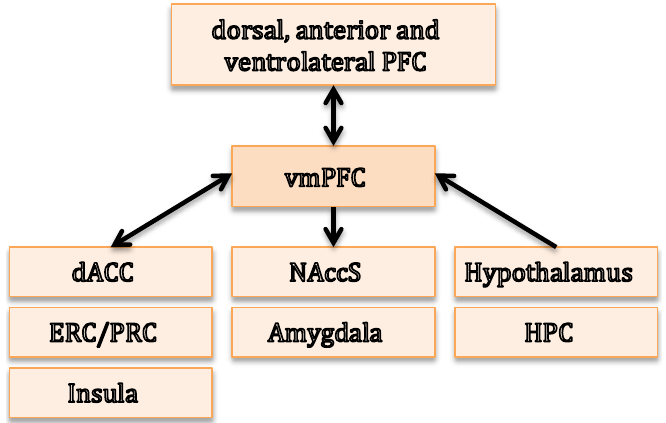
Figure 3. Principal connections from and to the ventromedial prefrontal cortex (vmPFC) adapted from [32]. dACC = dorsal anterior cingulate cortex; ERC = entorhinal cortex; PRC = perirhinal cortex; NAccS = nucleus accumbens shell; HPC =